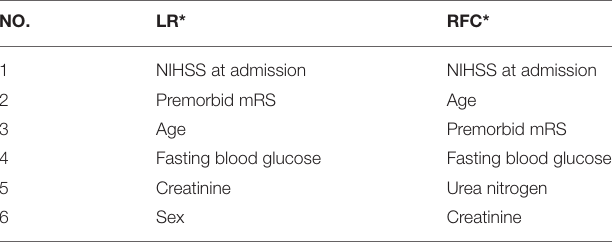
TABLE 4 | Top 6 important features in the models with 21